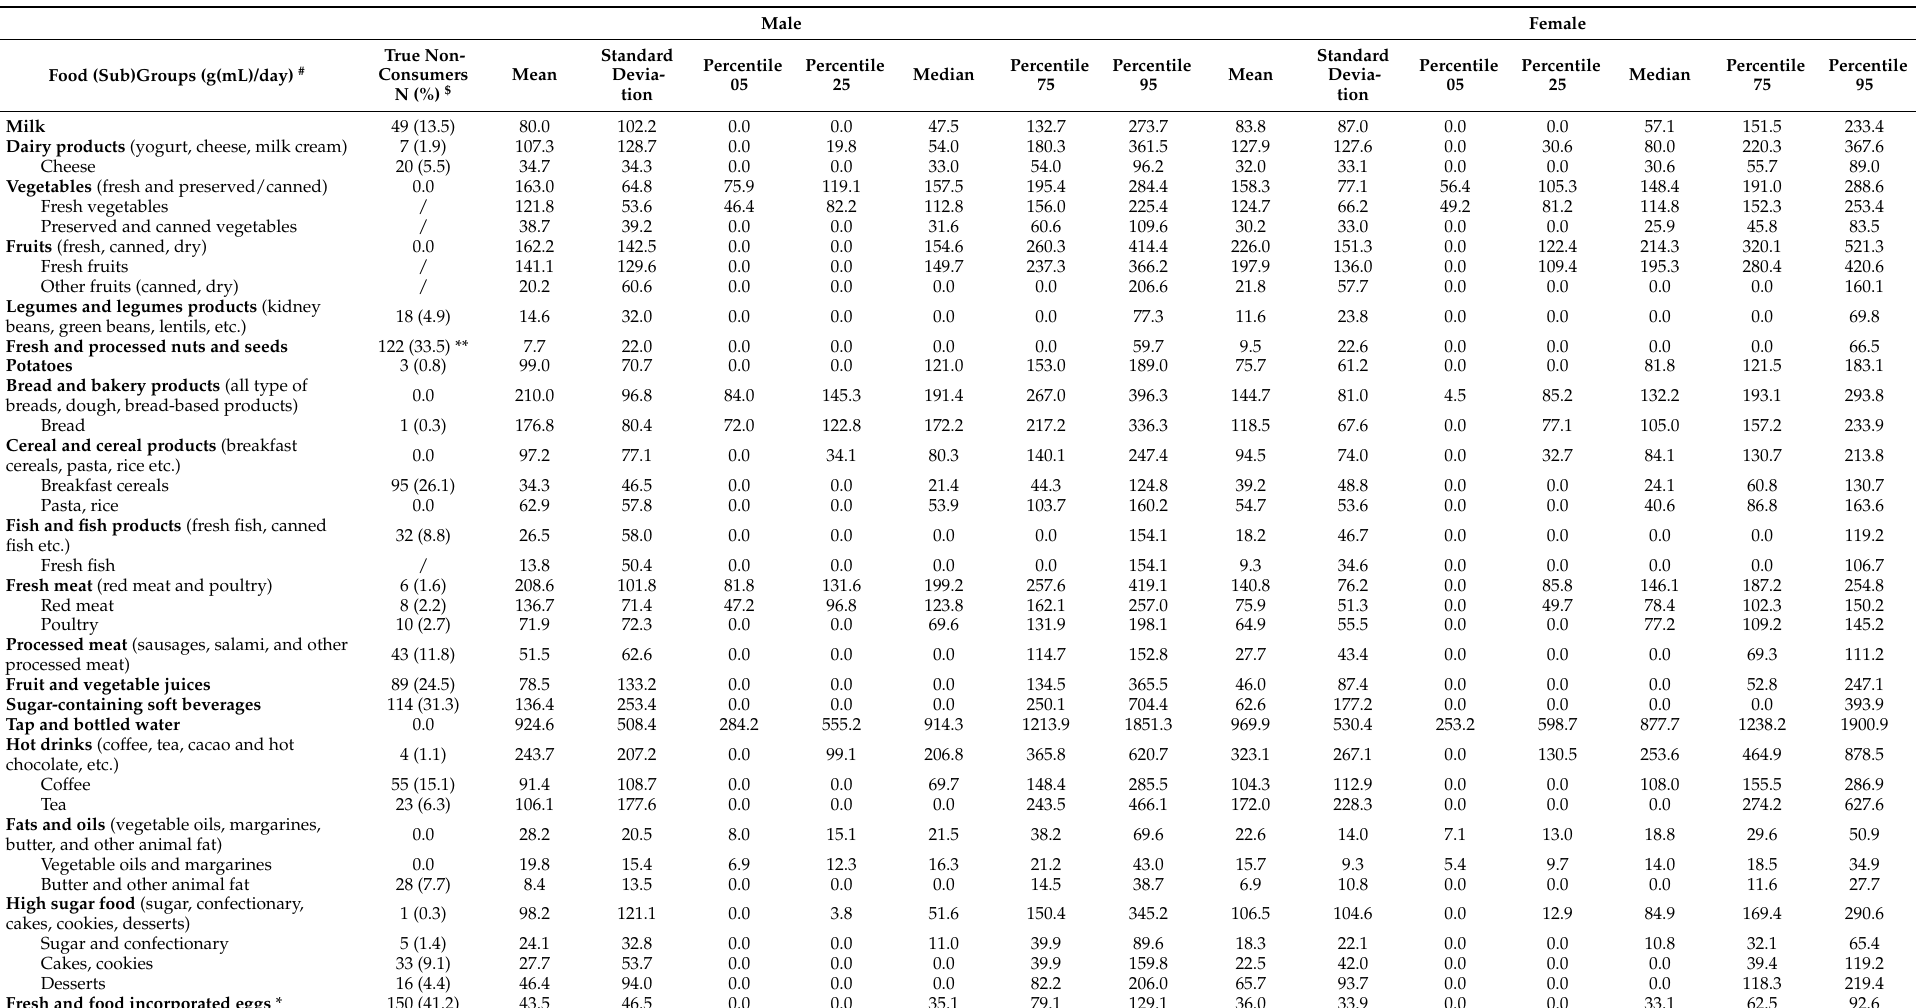
Table 2. Descriptive statistics of usual daily intakes of food groups among male and female adults (18–64 years). Male